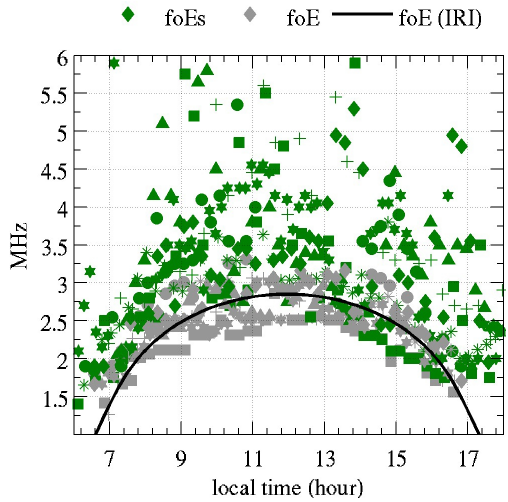
Figure 11. Local time variation of the sporadic E layer critical fre- quency (foEs, green) and the E layer critical frequency (foE, grey) observed by seven selected ionosondes and the corresponding IRI modeled foE results (black line) during 2006.294. The results of different ionosondes are distinguished by the dot shape. The IRI model results are corresponding to the mean latitude and longitude of seven ionosonde